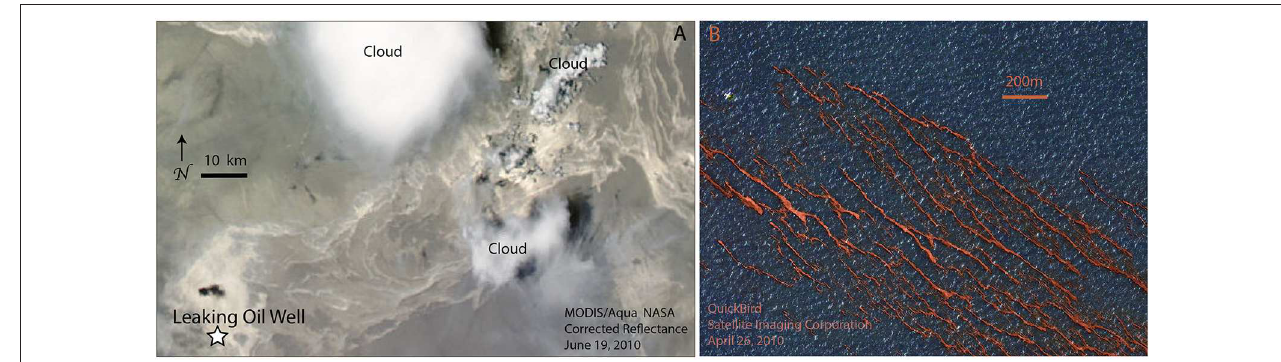
FIGURE 1 | Distribution of floating oil from the Deepwater Horizon spill. (A) On scales of 1–100 km (Image provided by NASA MODIS). (B) On scales of 1–1,500 m (Satellite Imagery Provided as a Courtesy by Maxar and Satellite Imaging